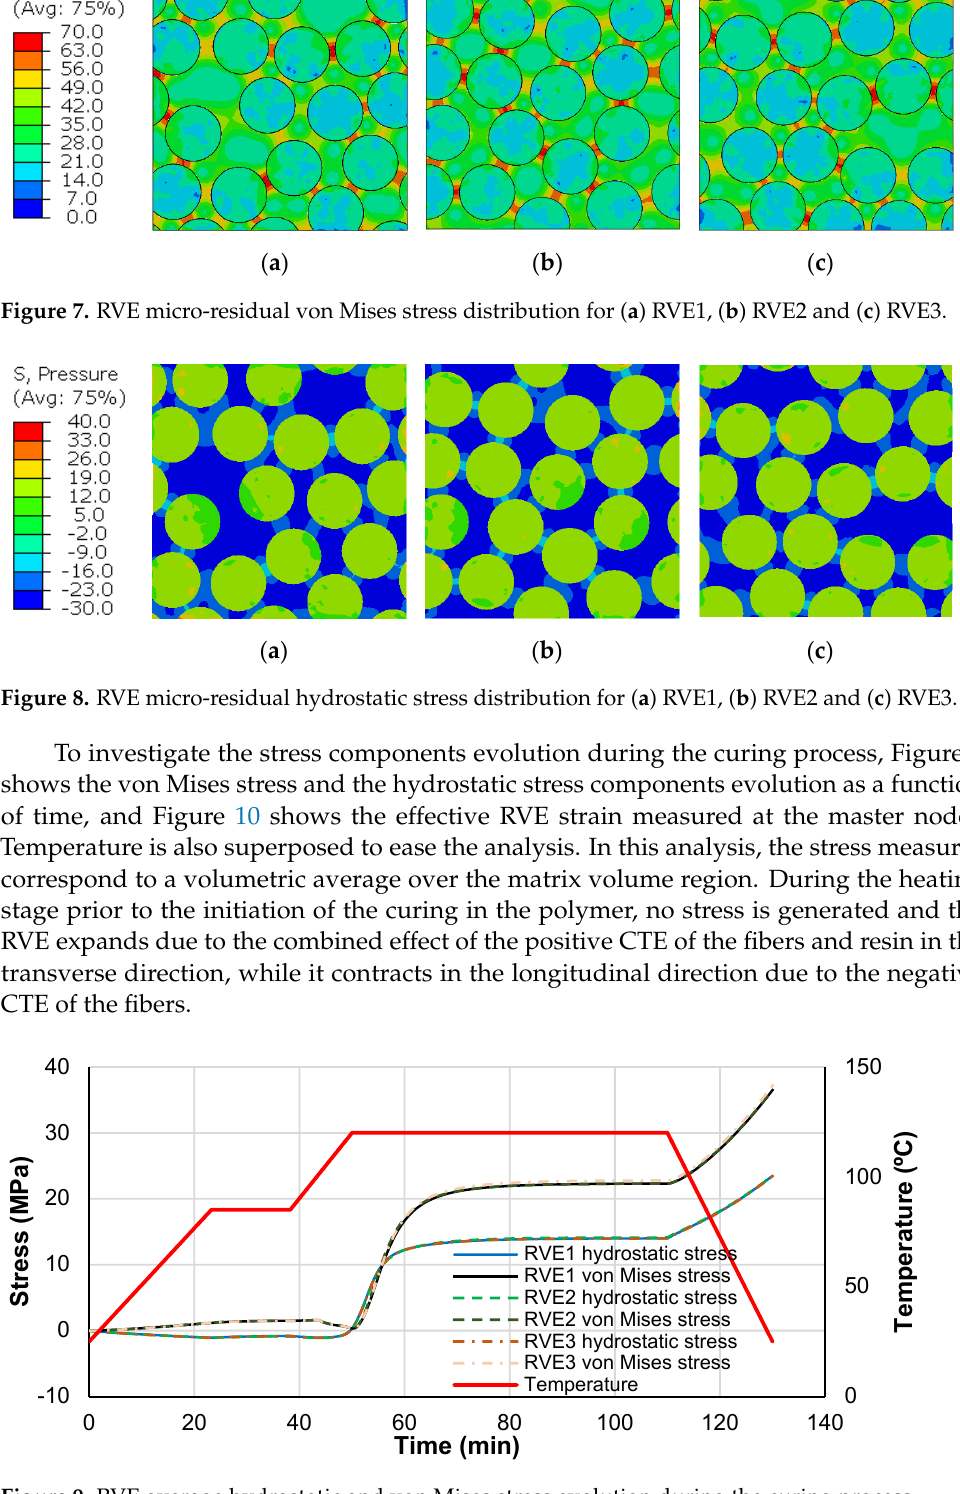
Figure 9. RVE average hydrostatic and von Mises stress evolution during the curing process.